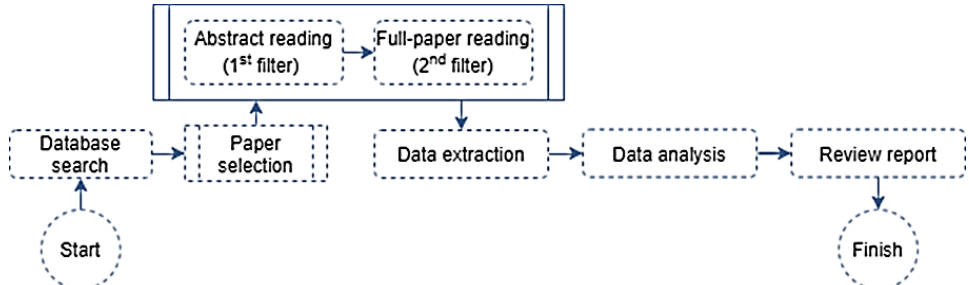
Figure 1. Steps of the systematic literature